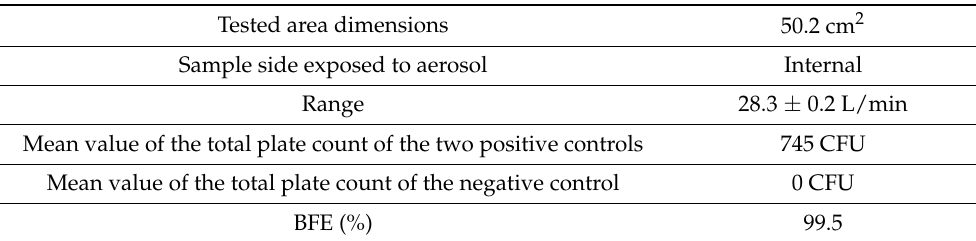
Table 5. Individual BFE values of FFP2 D. All samples exceeded the breathability and bacterial filtration tests (BFE). A BFE value greater than or equal to 98% was found on all samples, as required by the UNI EN 14683: 2019 + AC: 2019 standard.